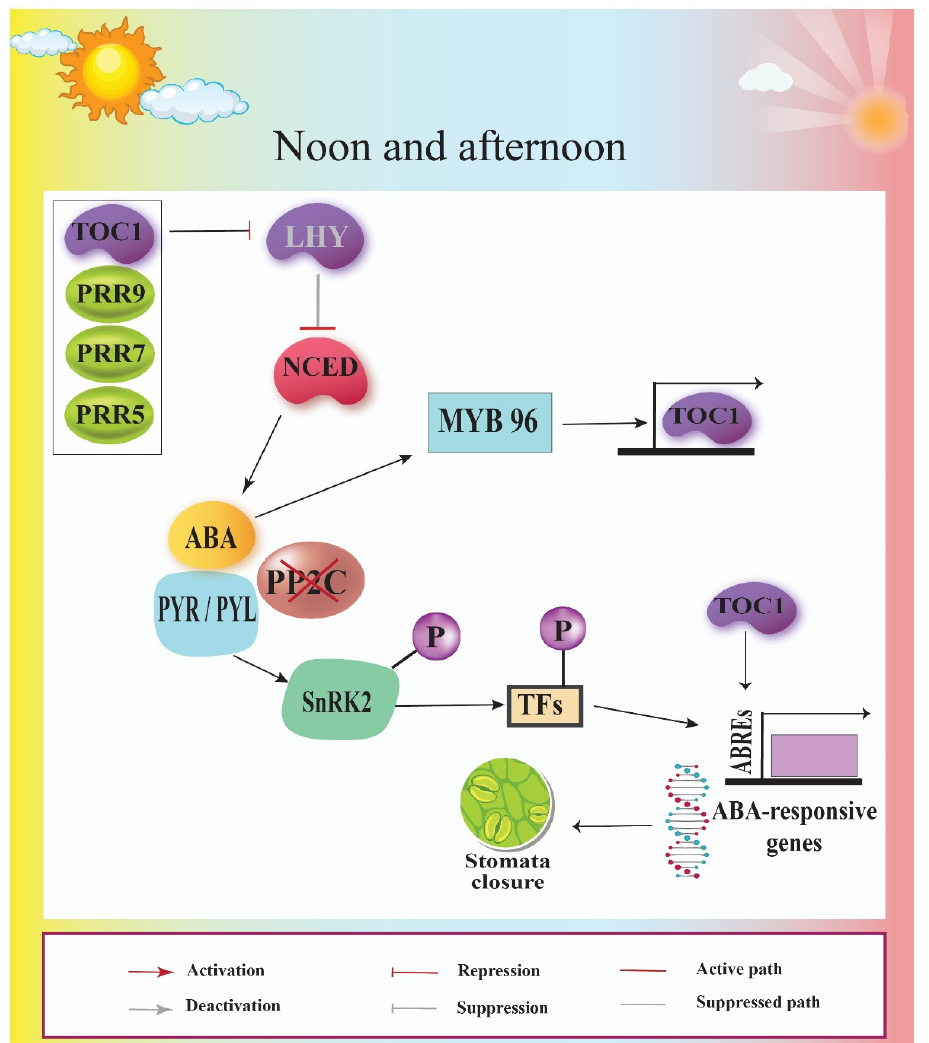
Figure 4. Scheme representing the signaling network of ABA regulatory pathway at the core of the circadian oscillator. In the morning, the biosynthesis of ABA is blocked through the negative impact of LHY on the NCED as the rate-limiting component of the ABA biosynthesis pathway. Later, following noon, when the plant gets rid of the negative impact of LHY on the NCED, ABA is present and its signal transduction pathway would activate the ABA-responsive genes, leading to stomatal closure.